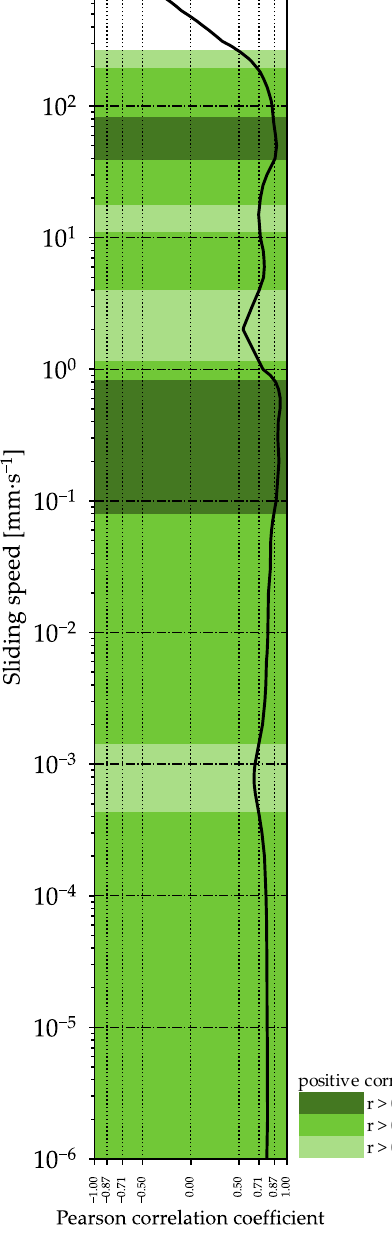
Figure 9. Pearson correlation coefficient for the interaction factor z and the coefficient of friction (COF) over the entire sliding speed range for curve 1 of the tribological measurements.